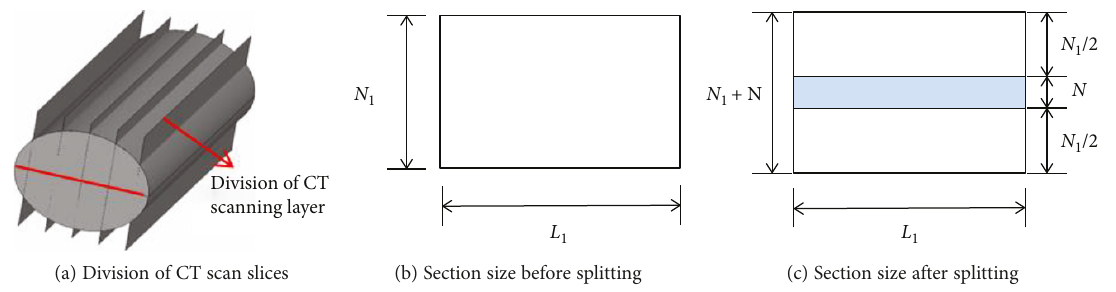
Figure 5: Schematic diagram of crack width calculation. Table 1: Mechanical parameters of coarse sandstone and fi ne sandstone.